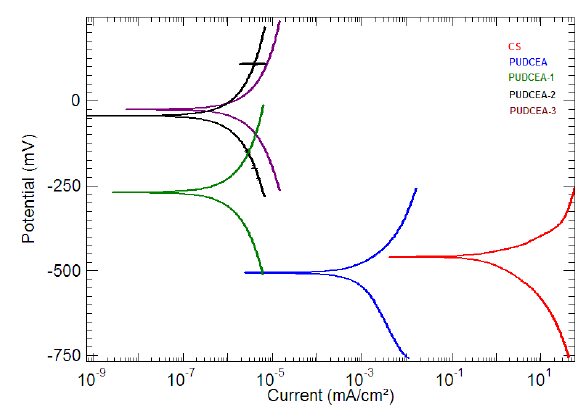
Figure 12: Tafel plot of bare CS, PUDCEA, PUDCEA-1, PUDCEA-2 andPUDCEA-3 in HCl solution.